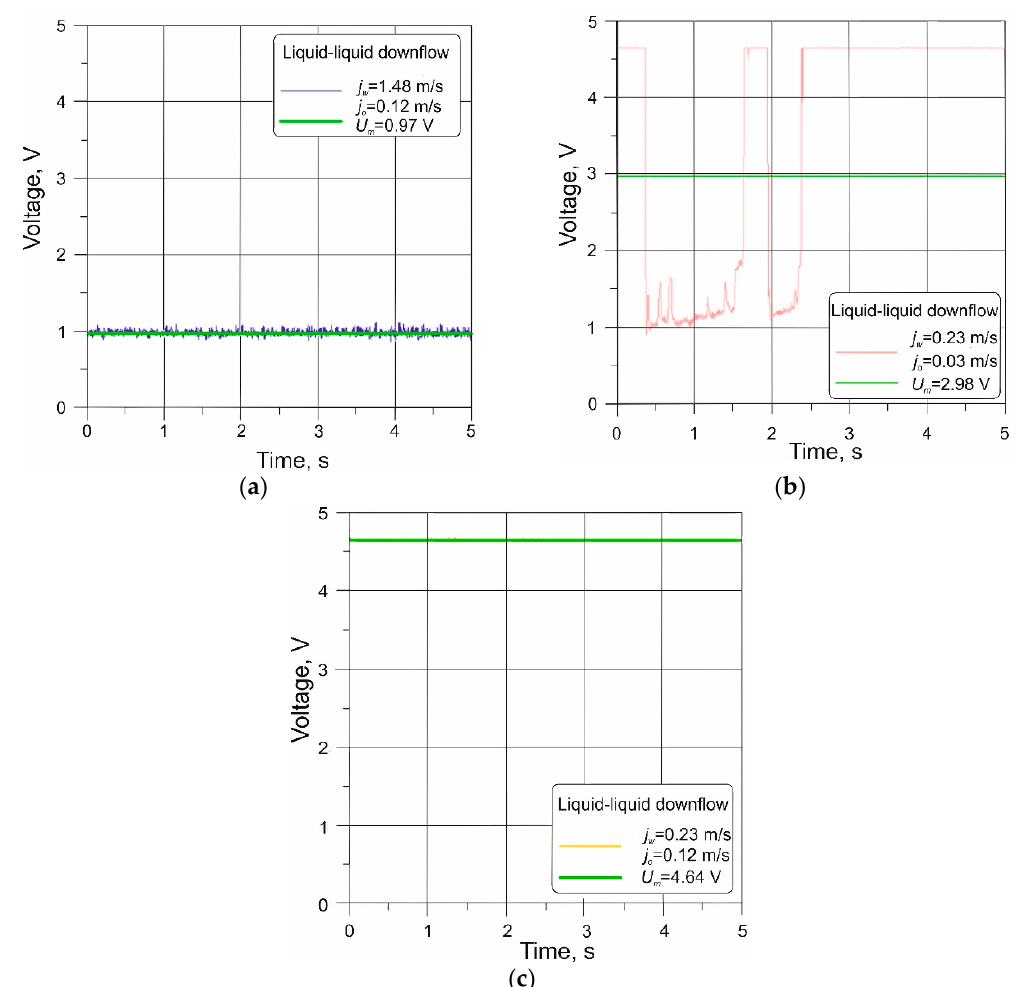
Figure 2. Actual waveforms of voltage variations during liquid–liquid flow: ( a ) water-dominated flow O/W, ( b ) emulsified oil O + W, ( c ) oil-dominated flow W/O. Table 2. The range of parameters change in multiphase mixture flow.